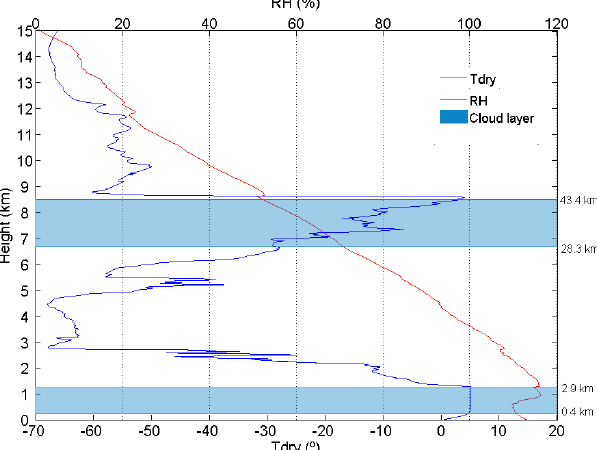
Figure 1. Temperature (Tdry ( ◦ ), in red) and relative humidity with respect to water (RH (%), in blue) profiles above ground level from the radiosonde on 5 October 2009 at 23:23h at SGP. Blue shad- ing represents the cloud layers as detected by ARSCL. The val- ues (on the right) related to every cloud layer boundary indicate the sonde horizontal distance from the ARSCL site in kilometers when it reached those